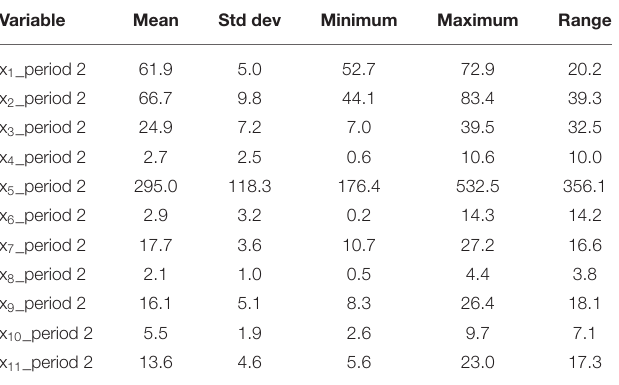
TABLE 3 | Relative and absolute changes of the indicators between period 1 and period 2. Variable Relative change,